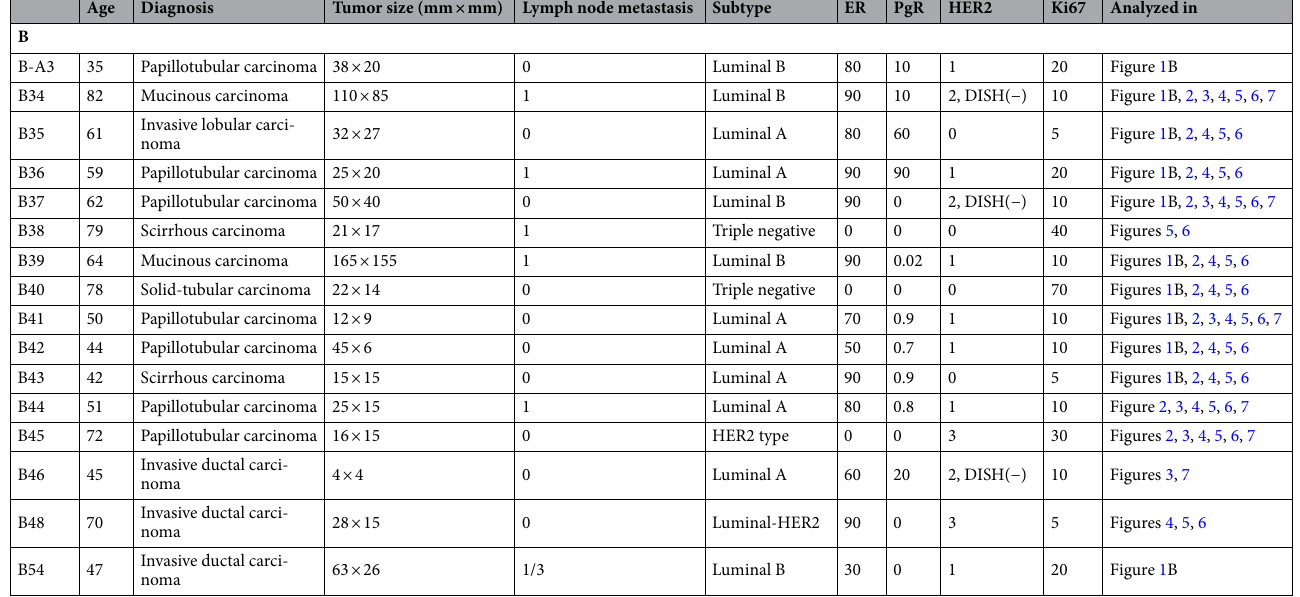
Table 1. Characteristics of the enrolled breast cancer patients. ER estrogen receptor; PgR progesterone receptor; HER2 Human epidermal growth factor receptor 2; DISH dual-color in situ